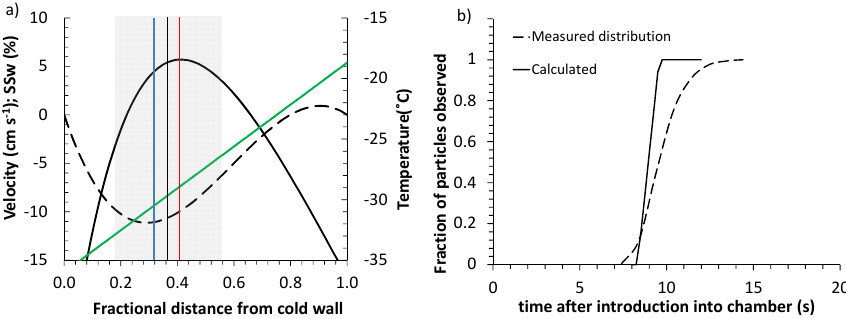
Figure B1. (a) A schematic depiction of a particle beam (shading) spread to a breadth of 4 times the ideal positions of the cold (blue) and warm (red) edges of the aerosol lamina on the basis of transit time measurements of a 1s wide aerosol pulse through the CFDC column (b) . The transit time measurement for a lamina central temperature of − 30 ◦ C and 105% RH w is compared to that calculated for a uniform distribution of particles residing fully within the aerosol lamina. Other calculated values in (a) are the temperature profile (green), SS w (solid black), and downward (negative) air velocity (dashed) in the gap between the CFDC walls.